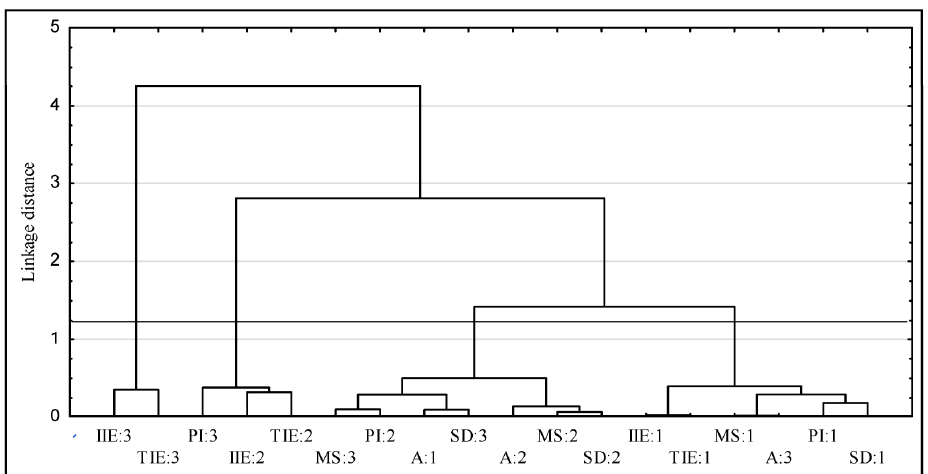
Figure 6. Hierarchical classification of variable categories performed with the use of Ward’s method.